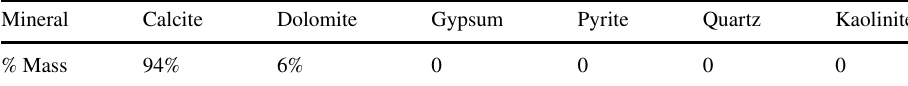
Table 2 XRD analysis of the carbonate reservoir samples